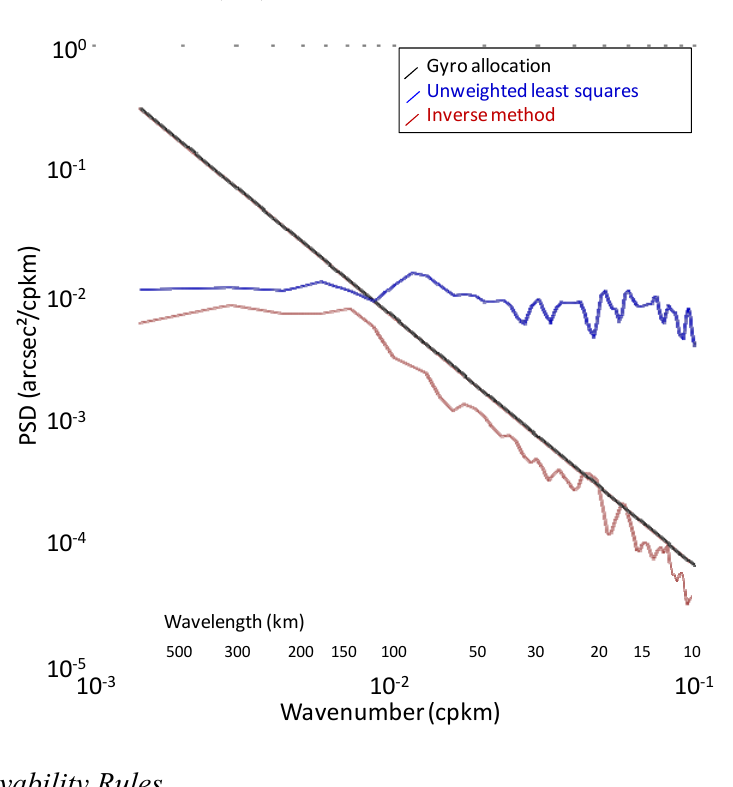
Figure 10. Spectral leakage of simulated KaRIN’s noise on roll with the sub-cycle calibration method (latitude 30°) when the problem is solved with unweighted least squares (blue) or with an inverse method